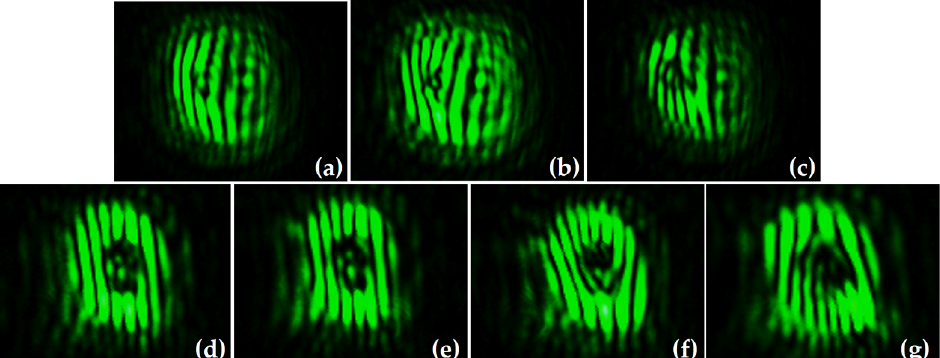
Figure 6. Off-axis interference of engineered light beams. Gaussian beam with ( a ) a Gaussian beam, ( b ) a vortex with m = 2, ( c ) a vortex with m = − 2. Vortices with charges ( d ) m 1 = − 2 m 2 = − 2, ( e ) m 1 = 2 m 2 = 2, ( f ) m 1 = 2, m 2 = − 2, and ( g ) m 1 = − 2, m 2 = 2.